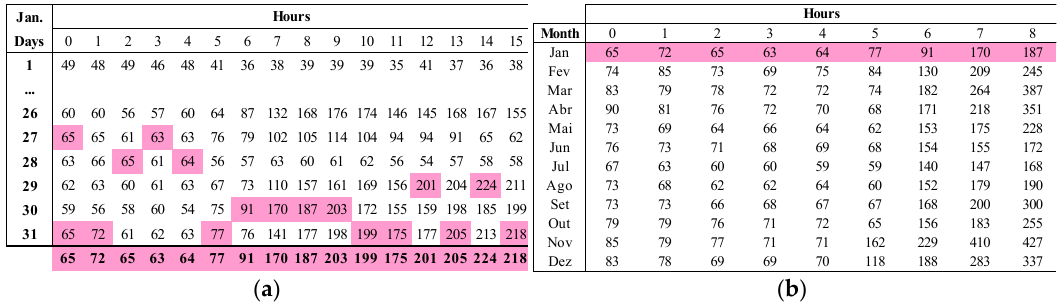
Figure 3. Demand records: ( a ) finding the highest daily values for January and ( b ) the highest hourly demand registered for each month.